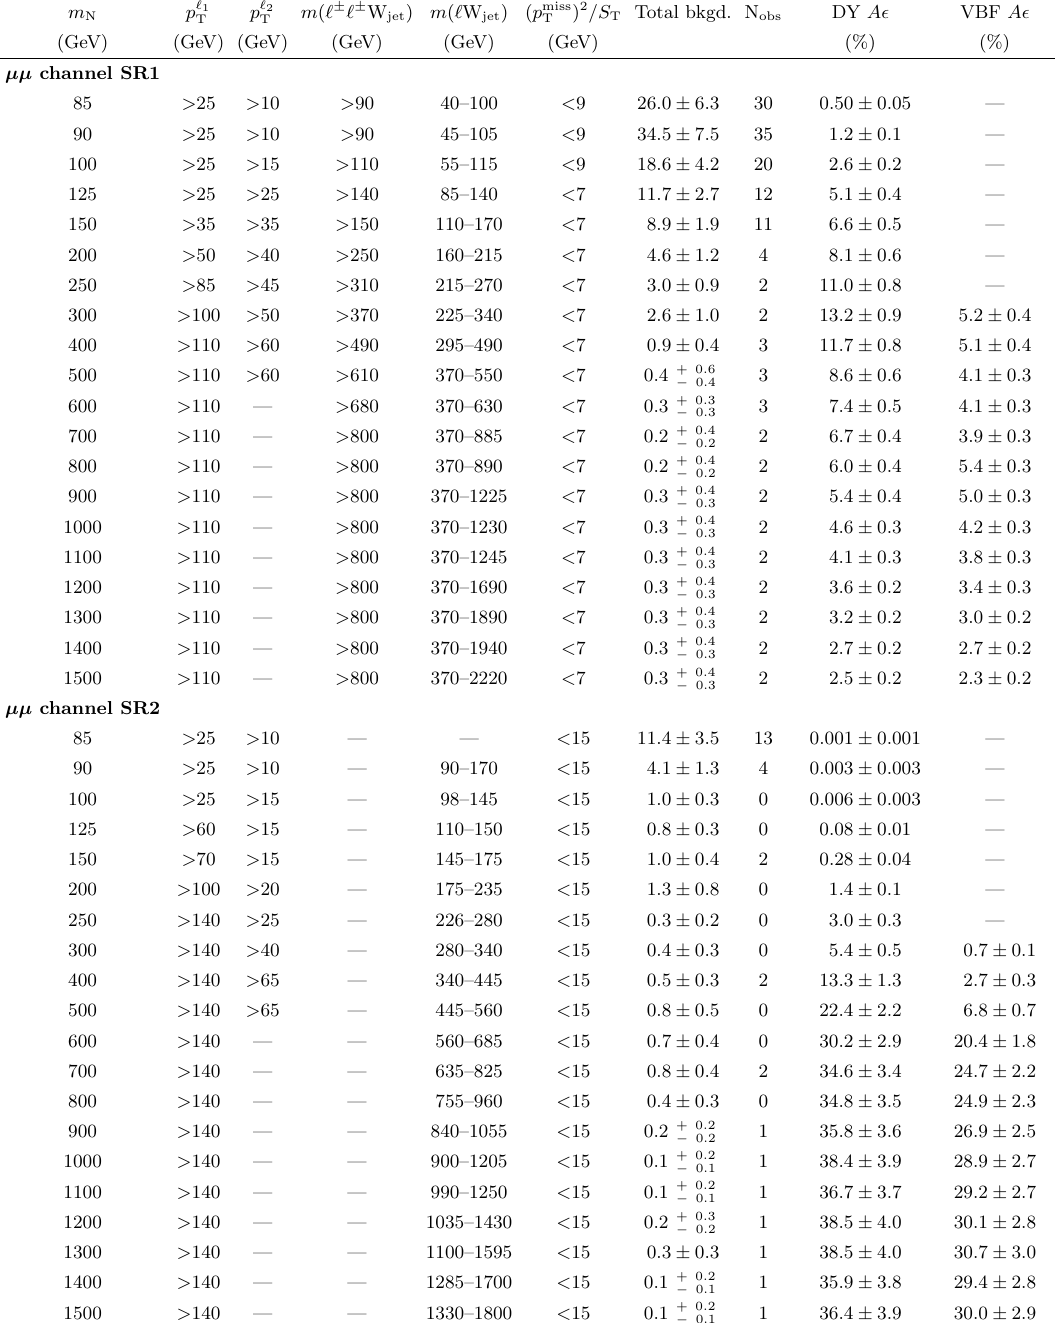
Table 9 . Selection requirements on discriminating variables determined by the optimization for each Majorana neutrino mass point in the (cid:22)(cid:22) channel high-mass SRs. Columns 7 and 8 show the total background yields (Total bkgd.) and the number of observed data (N obs ), respectively. The last columns show the overall signal acceptance for the DY and VBF channels. The quoted uncertainties include both the statistical and systematic contributions. The dash indicates that no selection requirement is made.